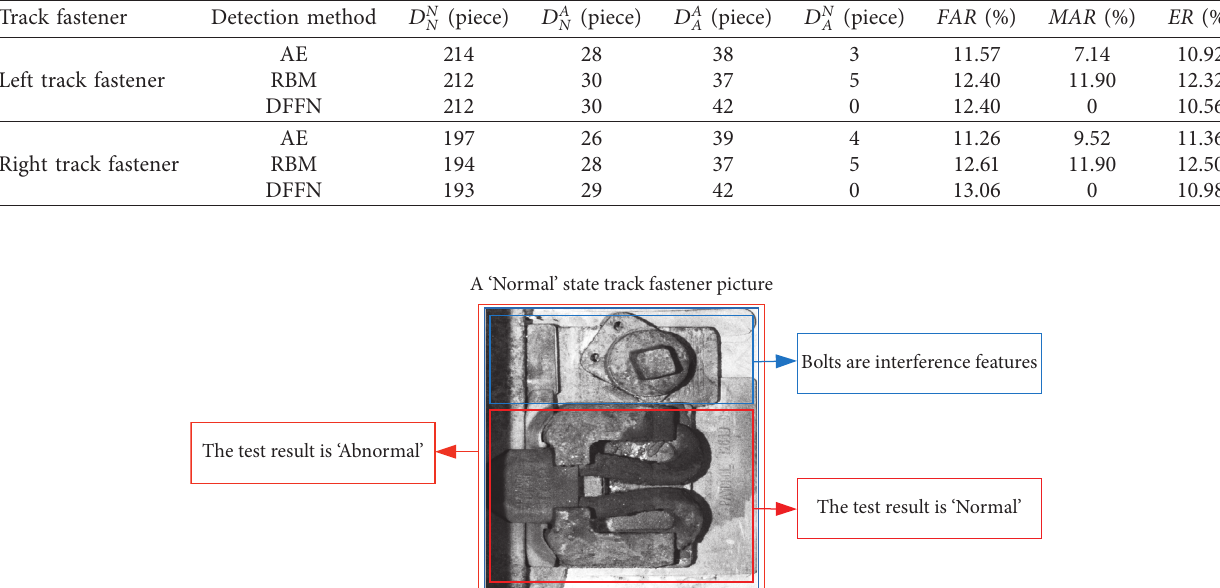
Table 1: Defects detection results of Pandrol track fasteners based on